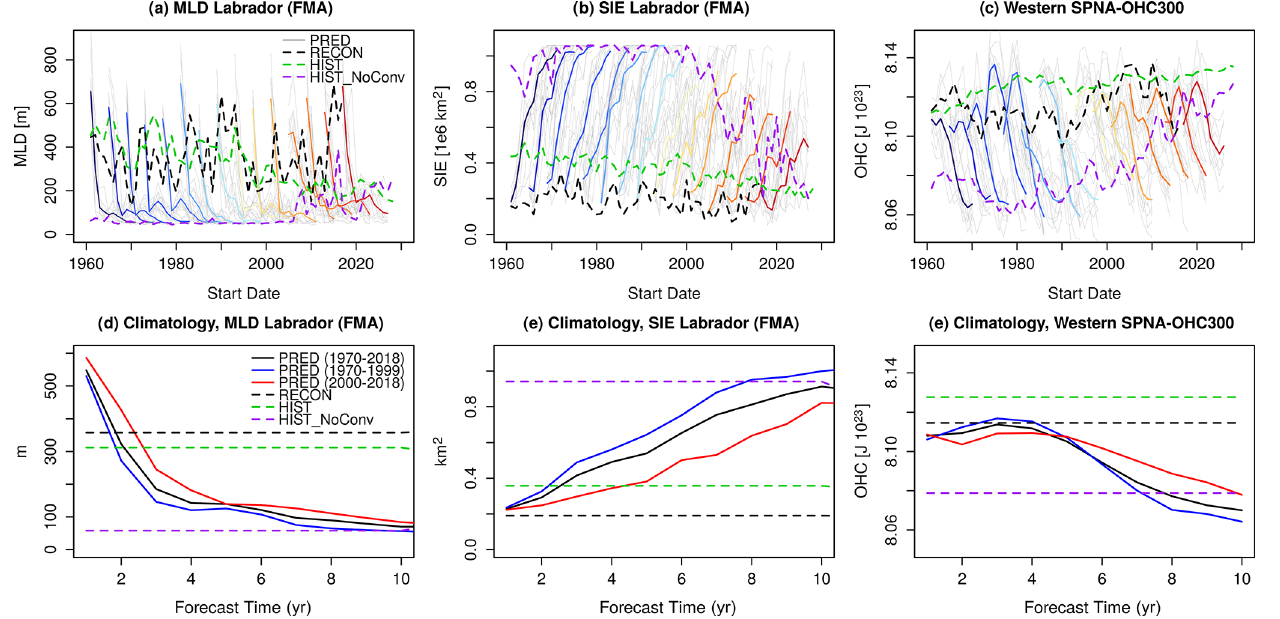
Figure 7. The same as in Fig. 6 but for the mixed layer depth (MLD) in the Labrador Sea in February–March–April (FMA), the sea ice extent (SIE) in the Labrador Sea during the same months and the western SPNA-OHC300 annual